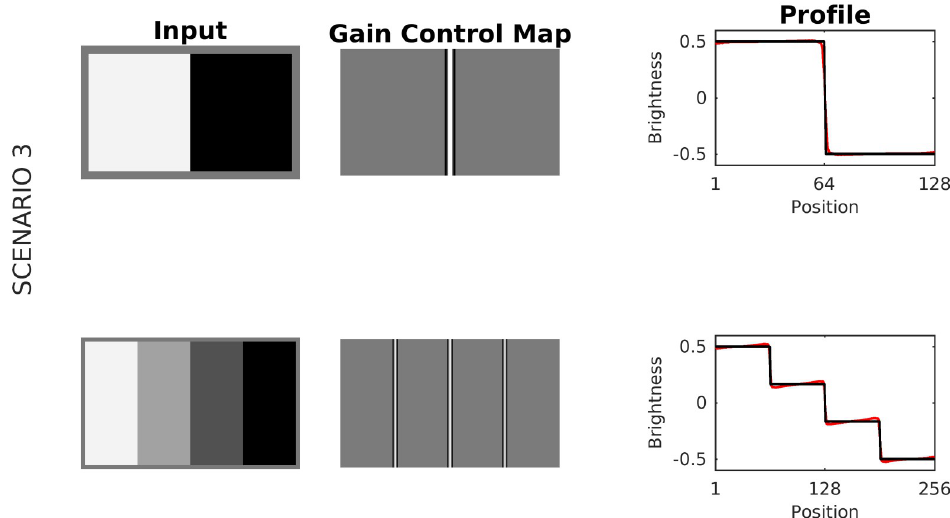
Fig 8. Scenario 3. A luminance step and a luminance staircase, respectively, served as input images. Activity in response to the luminance step is close to the control parameter of Eq 4 ( τ = 0.5), producing barely changes in the corresponding brightness estimation at the edges. In contrast, for the luminance staircase, the activity at the edges is relatively far from the control parameter, inducing a boost (an increment of brightness contrast) in the corresponding brightness estimation.